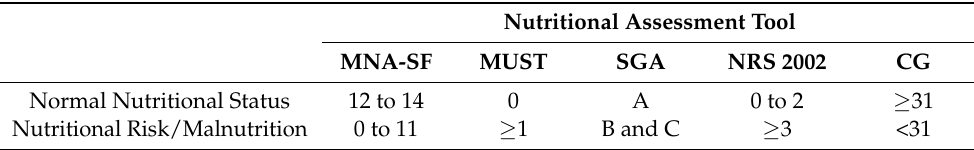
Table 1. Sample nutritional status classified in two categories, even if the tool implemented typically incorporated 3 categories.